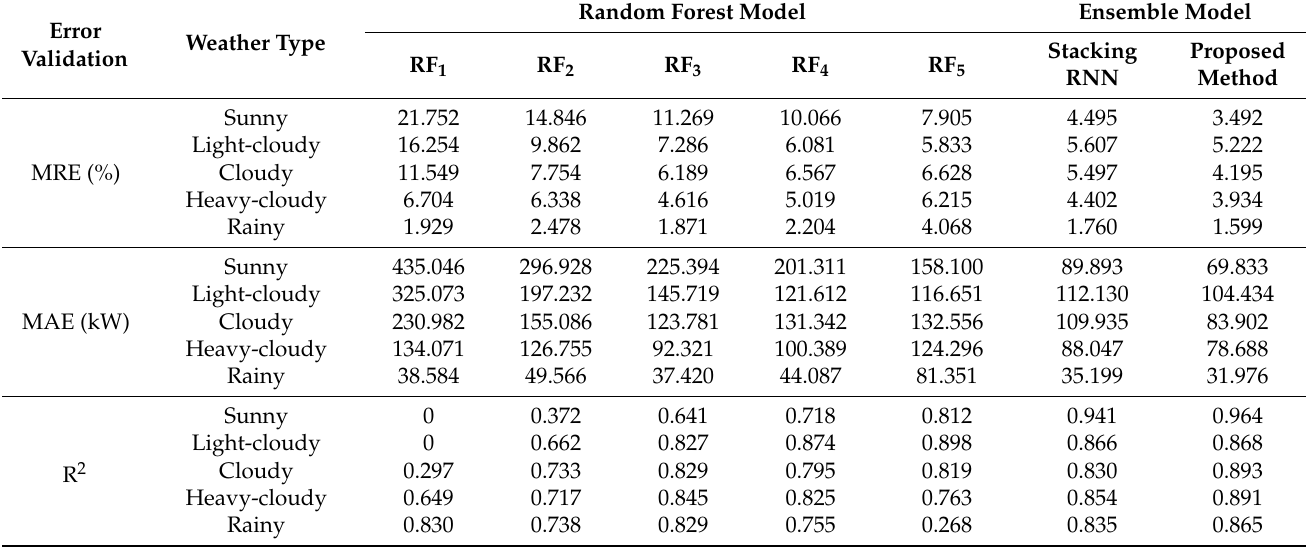
116.651 kW and 112.13 kW. Table 6. Forecasting accuracy for all weather